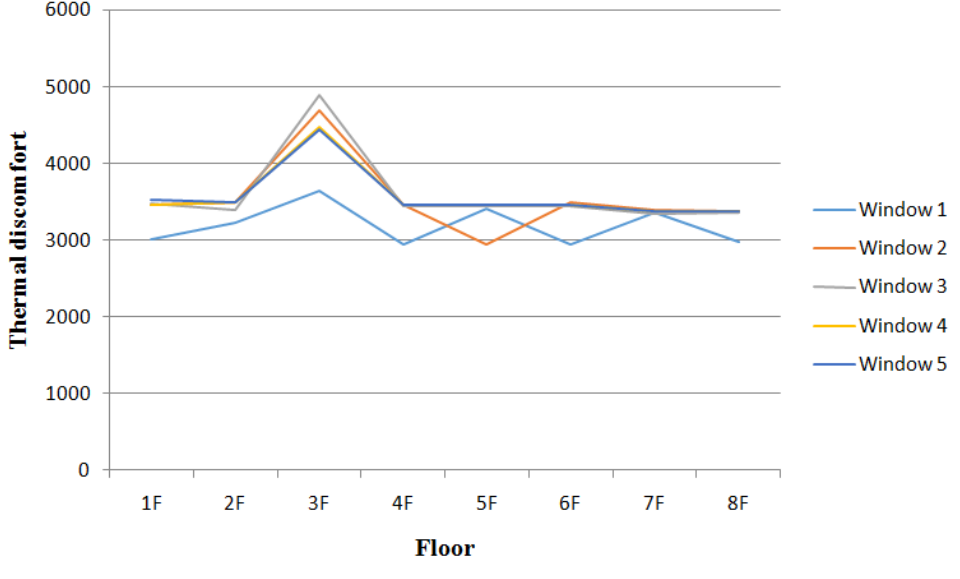
Fig. 10 Comparison of thermal discomfort of each